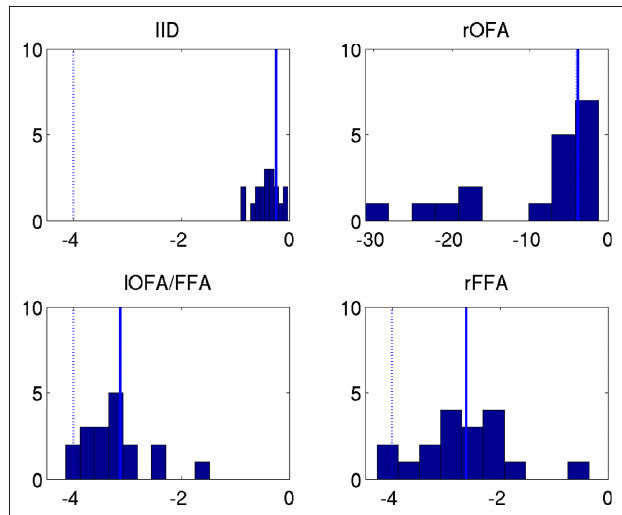
Figure 11 | The hyperparameter estimates ( ) (2) ˆ  for the MMN source prior (top left) and three fMri source priors (remaining plots; OFA, occipital face area; FFA, fusiform face area; l , left, r, right). The solid bars constitute a histogram of estimates across subjects without group- optimization; the solid line reflects the single estimate after group-optimization across subjects; and the dotted line shows their prior expectation (  ( ) ) 2 4 = − . Note the different scale of the x -axis in the top